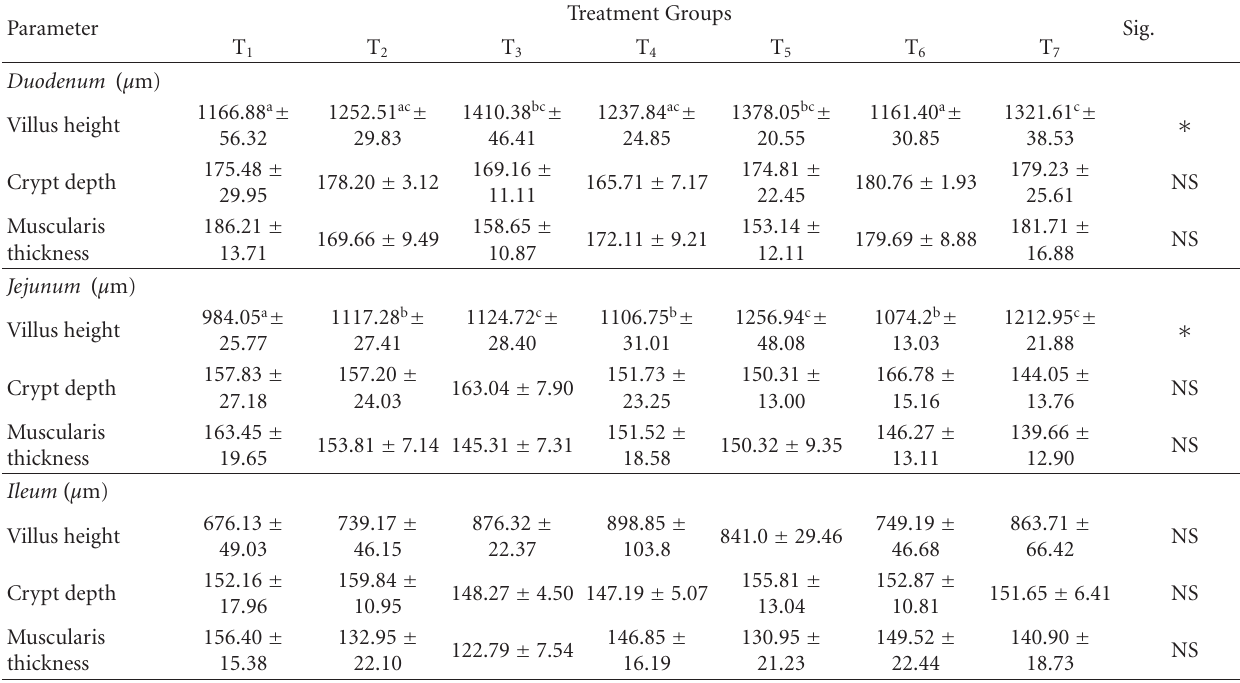
Table 3: E ff ect of organic acid supplementation on histomorphology of small intestines of broiler chicken.